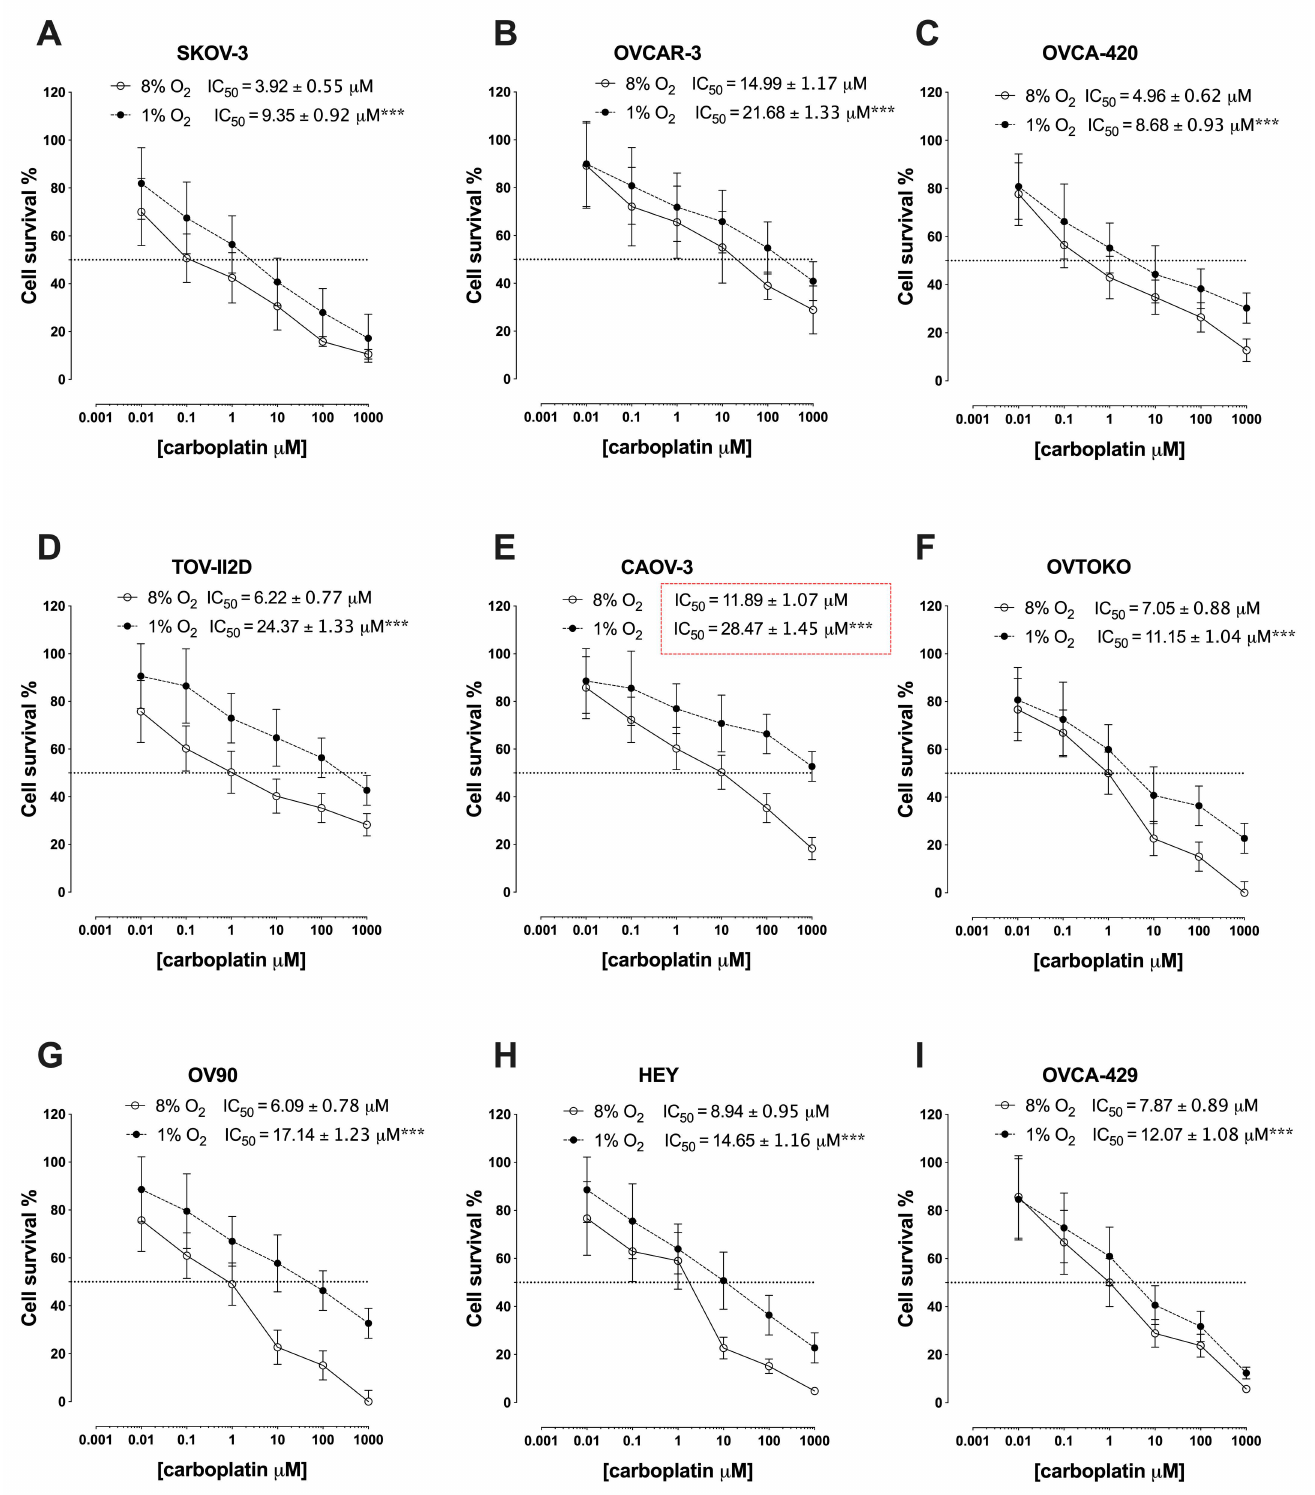
Figure 1. IC50 of a panel of epithelial ovarian cancer cells. The cells (( A – I ): SKOV-3, OVCAR-3, OVCA-420, TOV-112D, CAOV-3, OVTOKO, OV-90, HEY, and OVCA-429) were exposed to either 1% O 2 or 8% O 2 and treated with carboplatin at different concentrations (0, 0.001 µ M, 0.01 µ M, 0.1 µ M, 1 µ M, 10 µ M, 100 µ M, and 1000 µ M) in the presence of Caspase-3/7 reagent. The viability of the cells was assessed using the IncuCyte™ real-time cell-imaging system every 2 h for 72 h. The data are represented by the mean ± SEM ( n = 6). The IC50 of all EOC cells in this study were higher under hypoxia than under normoxic in their parental cells. *** p < 0.0005 at 1% oxygen compared with 8%